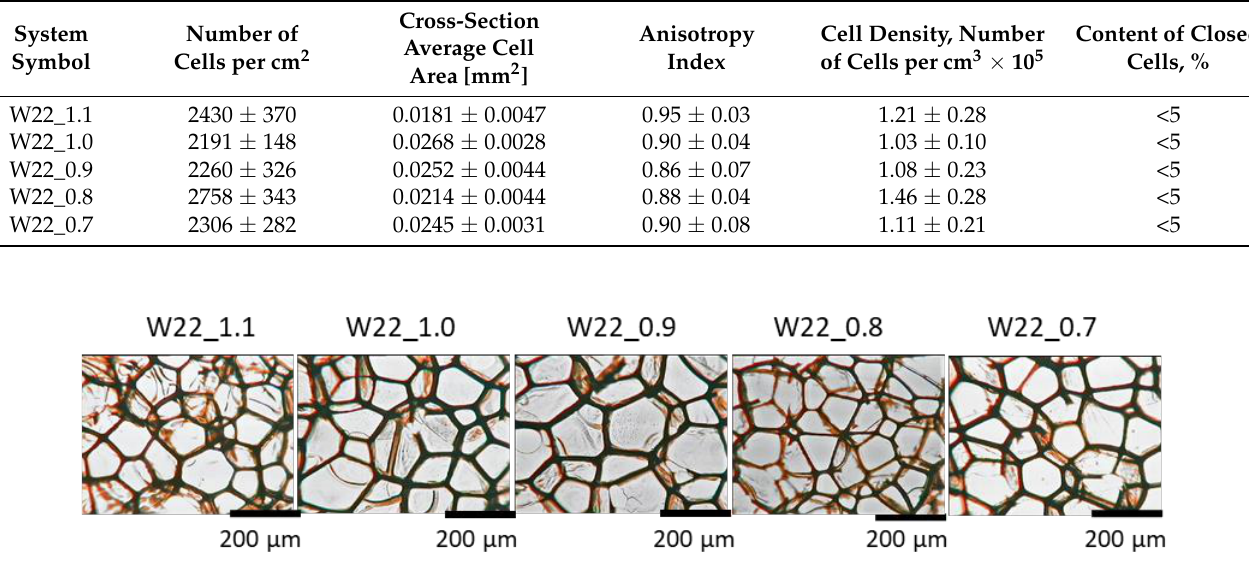
Table 5. Characteristics of the cellular structure of PU foams with different isocyanate indices.